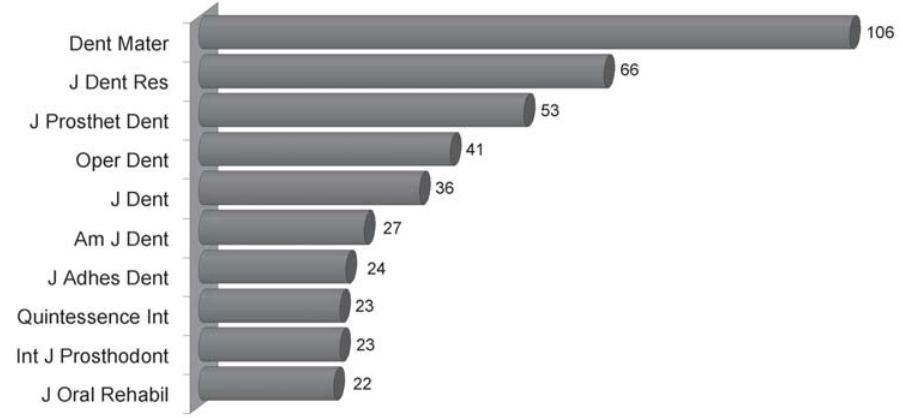
FIGURE 5- Journals of the area of Dental Materials most frequently cited in the JAOS between 2005 and 2007